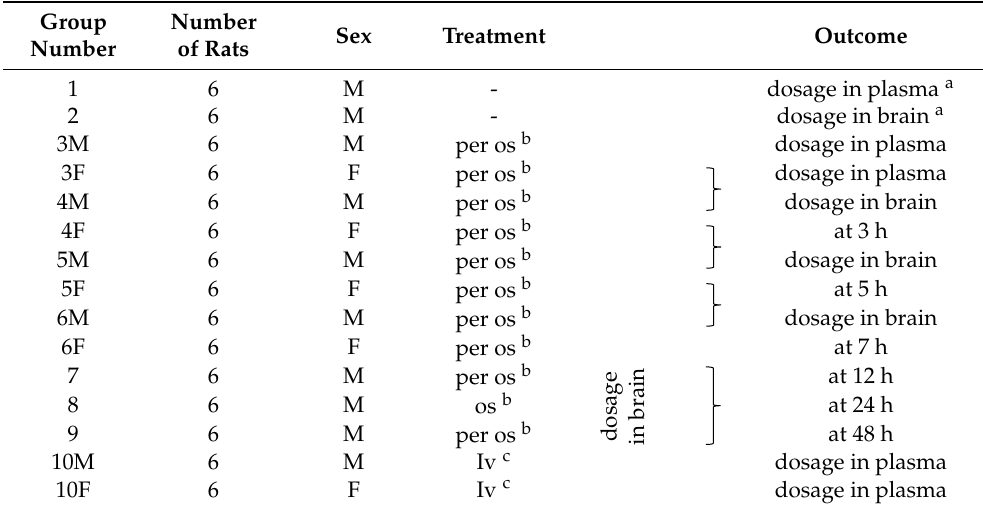
F Iv c dosage in plasma a With spiked amounts of TDMQ20 (controls). b Intragastric delivery of 25 mg/kg of TDMQ20 in 0.9